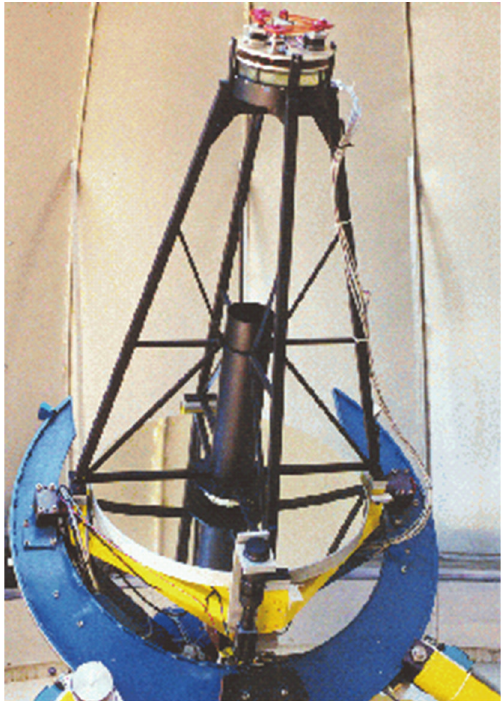
Figure 6: The 0.76 m KAIT telescope, adapted from [28].